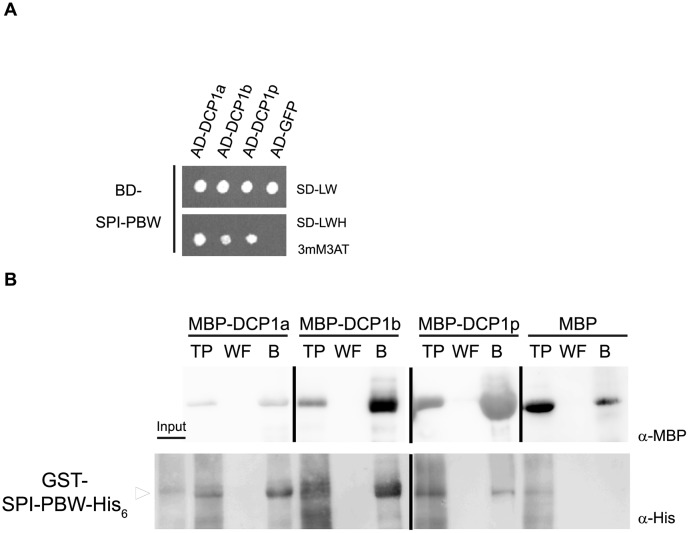
Interspecific interactions between SPI-PBW and DCP1 homologs from mammals and yeast.(A) Yeast two-hybrid interactions. Top part: double transformed yeast cells on selective dropout medium lacking leucine (-L) and tryptophan (-W). Bottom part: interactions between the SPI-PBW N-terminally fused to the GAL4 Binding Domain (BD) and the human DCP1 isoforms (DCP1a and b) and yeast DCP1p, N-terminal fused to the GAL4 Activation Domain (AD) on selective dropout medium lacking leucine (-L), tryptophan (-W) and histidine (-H), supplemented with 3 mM 3-Aminotrizole (3AT). GFP N-terminal fused to the GAL4-AD has been included as negative control. (B) Coprecipitations of bacterially expressed proteins. GST-SPI-PBW-His6 (arrowhead, ~110 kDa) coprecipitated with MBP-DCP1a (~90 kDa), MBP-DCP1b (~92kDa) and MBP-DCP1p (~60 kDa), but not with MBP (~42 kDa) as negative control. Throughputs (TP), last wash fractions (WF), and resin bound fractions (B) are visualized by α-MBP (upper row) and α-His6 antibody staining (lower row). Samples detected on different blots are separated by lines.